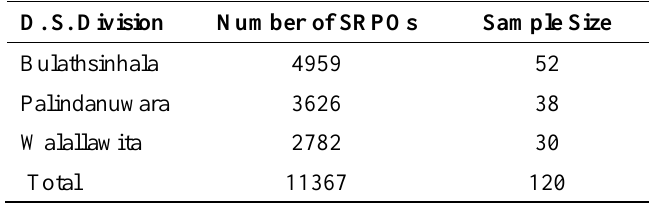
Table 1: Population and Sample Size of Each D. S.